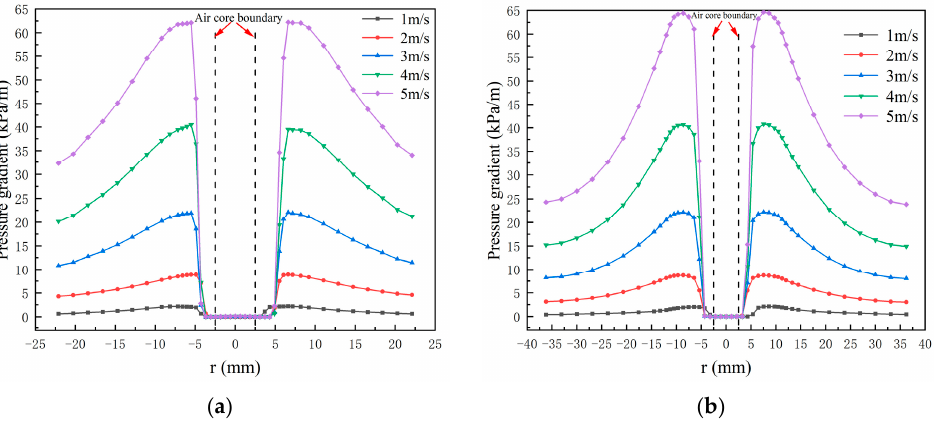
Figure 6. Distribution of the pressure gradient. ( a ) z 1 = 90 mm; ( b ) z 2 = 170